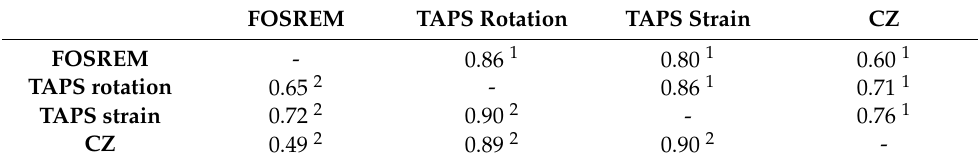
Figure 11. Maximum velocities of the rotation and symmetric strain motions in the rock mass, ob- tained from two sets of TAPS, were plotted against the maximum velocities of the rotational motions recorded with FOSREM due to the same 16 multiple blasts directed vertically from above.